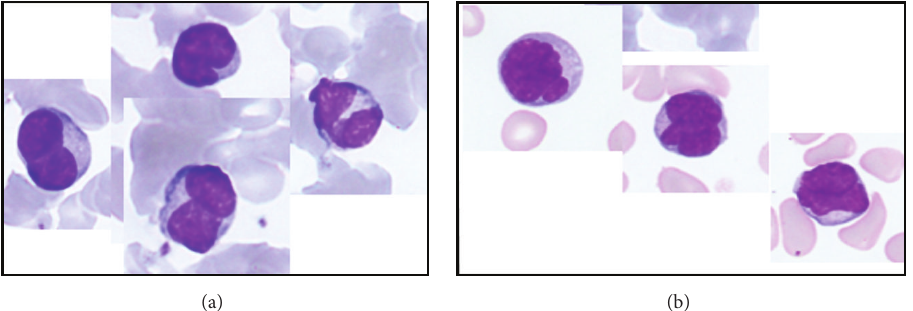
Figure 2: Lymphocytes with atypical convoluted nuclei: (a) in case 1 and (b) in case 2 (May-Gr¨unwald-Giemsa stain; original magnification, ×